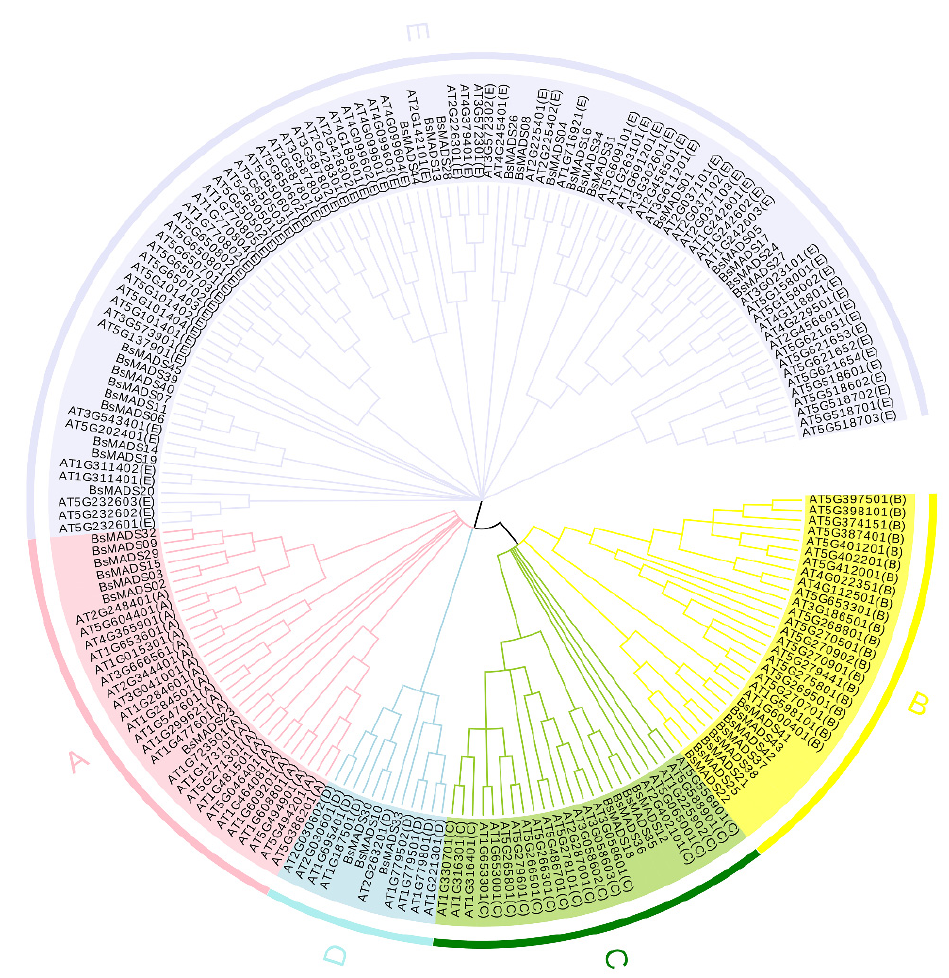
Figure 3. Phylogenetic tree of the MADS-box family proteins in B. striata and Arabidopsis . The unrooted neighbor-joining (NJ) tree was based on the amino acid sequences of AtMADS from B. striata (45) and Arabidopsis (146) using MEGA7 with 1000 bootstrap replicates. The names of the (A-E) groups shown outside the circle indicate different MADS subgroups—A (M α ), B (M β ), C (M γ ), D (M δ ), and E (MIKC); A, B, C, and D groups belonged to type I, and E groups belonged to type II.